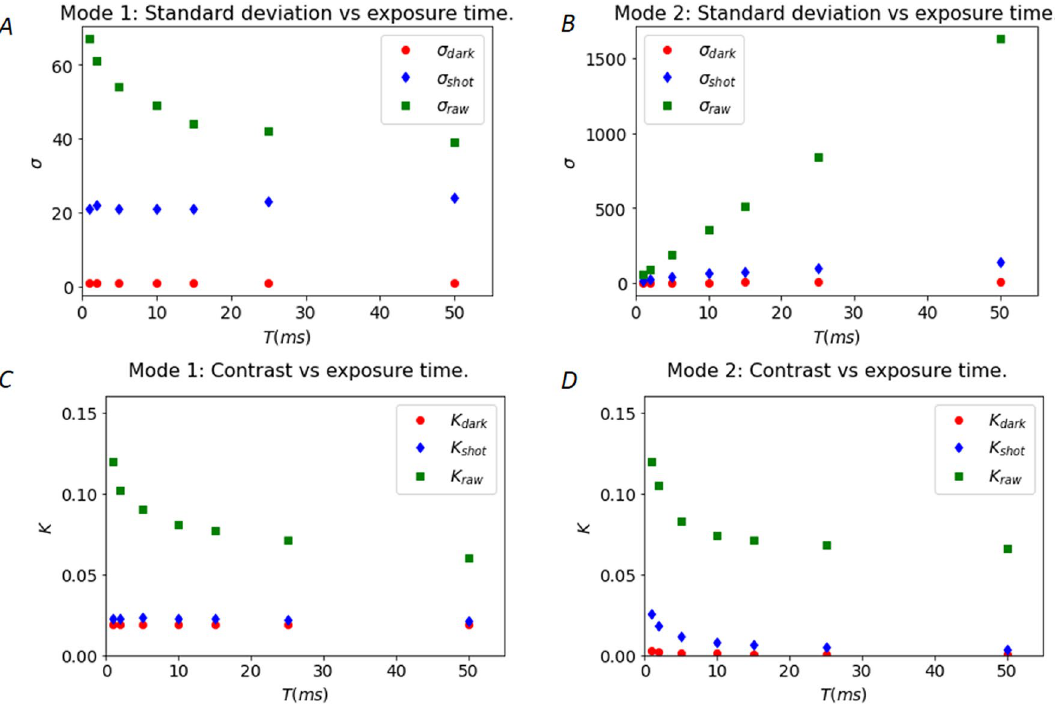
Figure 2. (A) Raw, dark and readout, and shot noise standard deviations in the modulated laser mode as a function of exposure time. (B) Same as (A) for the synthetic exposure mode. (C) Raw, dark and readout and shot noise speckle contrasts for the modulated laser mode. (D) Same as (C) for the synthetic exposure mode.